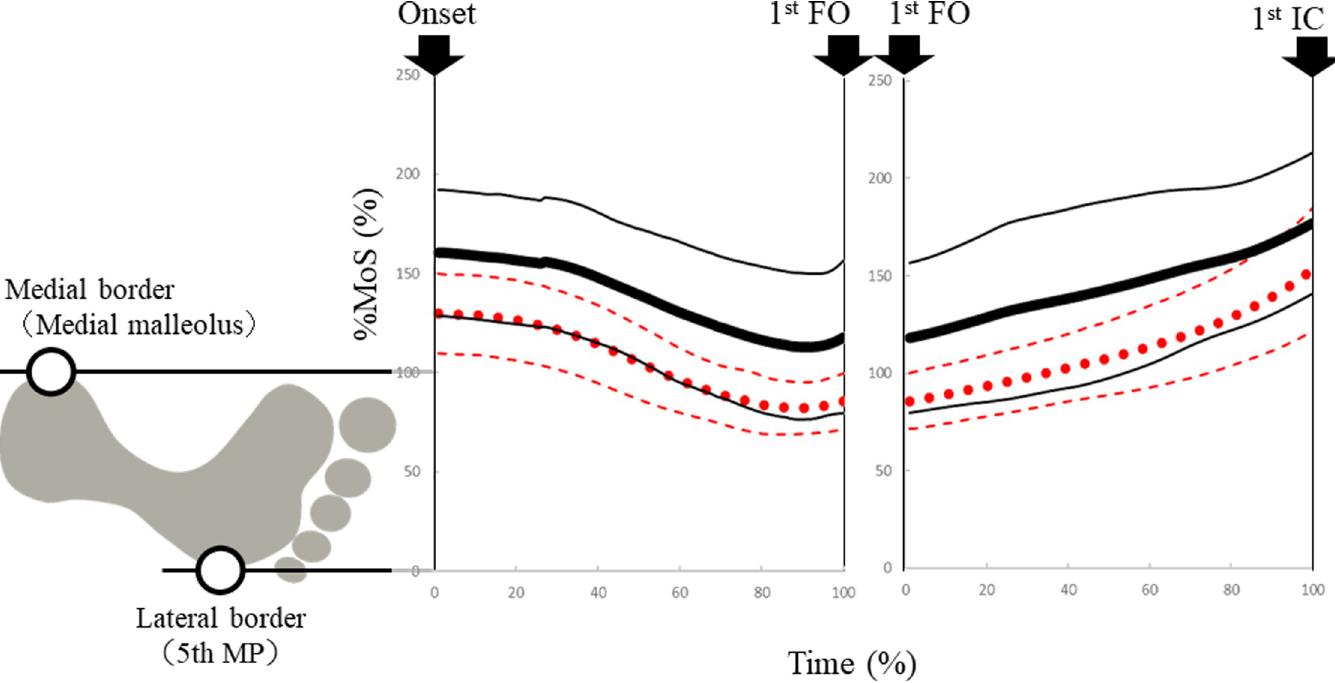
Fig 3. Differences in the average %MoS between tasks performed using paretic and non-paretic leading limbs (n = 38). The solid line indicates the task performed using the non-paretic leading limb. The dotted line indicates the task performed using the paretic leading limb. Dashed lines around the dotted line for the paretic leg and fine solid lines for the non-paretic leg indicate the standard deviation. The trajectories were obtained for the averaged trial of each subject with GI begun as quickly as possible from a static standing position. The horizontal axis is time (%), which is normalized to 100% each from onset to first foot off and from first foot off to first initial contact. The vertical axis is the distance (%) from the lateral boundary of the BoS to Xcom. The illustration of the foot is an image of the mediolateral position of the first stance foot. Mediolateral BoS (5 th MP to medial malleolus) is normalized to 100, with negative values indicating instability in the lateral direction. Abbreviations: 5th MP, fifth metatarsal-phalangeal joint; BoS, base of support; CoM, center of mass; FO, foot off; IC, initial contact; MoS, margin of stability; Xcom, extrapolated center of mass.